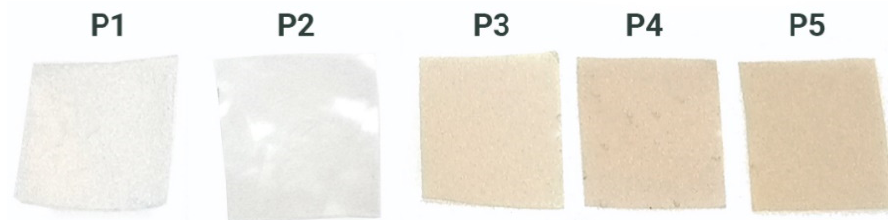
Figure 1. Visual appearance of pectin-based films.